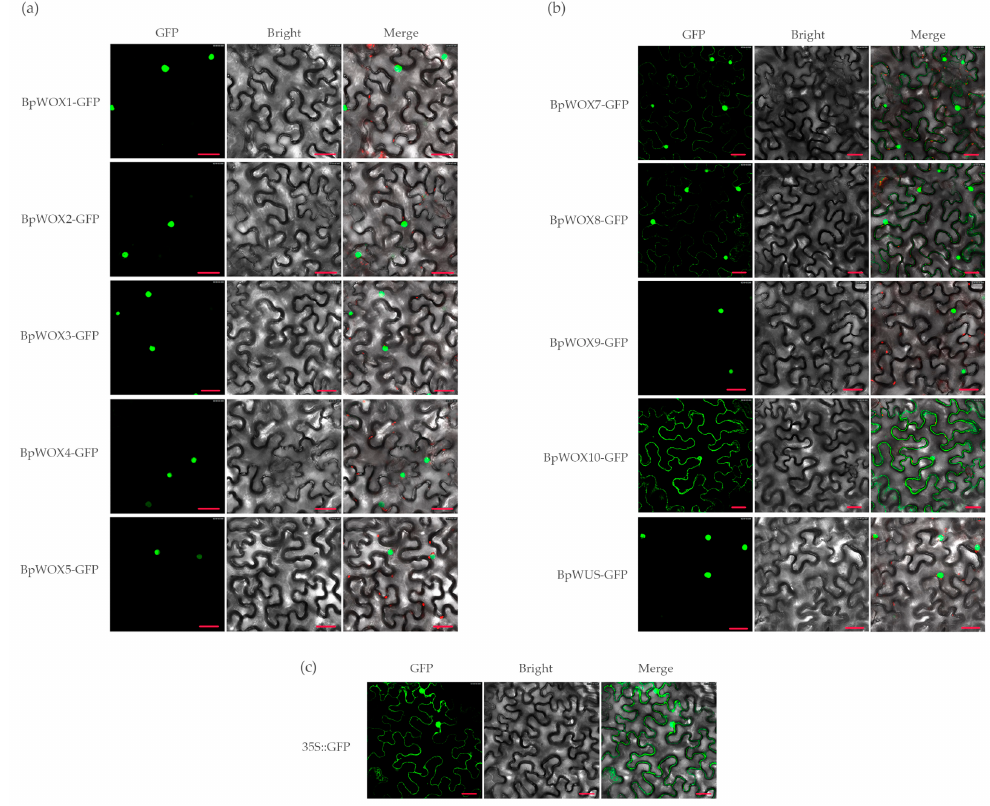
Figure 5. Subcellular localization of BpWOX proteins in N. benthamiana . Transient expression of the BpWOXs-GFP fusion protein was performed in tobacco epidermal cells. ( a ) Subcellular localization of BpWOX1 to BpWOX5; ( b ) Subcellular localization of BpWOX7 to BpWOX10 and BpWUS; ( c ) The GFP was used as a positive protein control and was detected in the nucleus and cytoplasm. Green fluorescence was observed using a confocal microscope at 48 h after A. tumefaciens infiltration. From left to right, the images show fluorescent-field illumination, bright-field, and overlay of three illuminations. Bar = 30 µm.